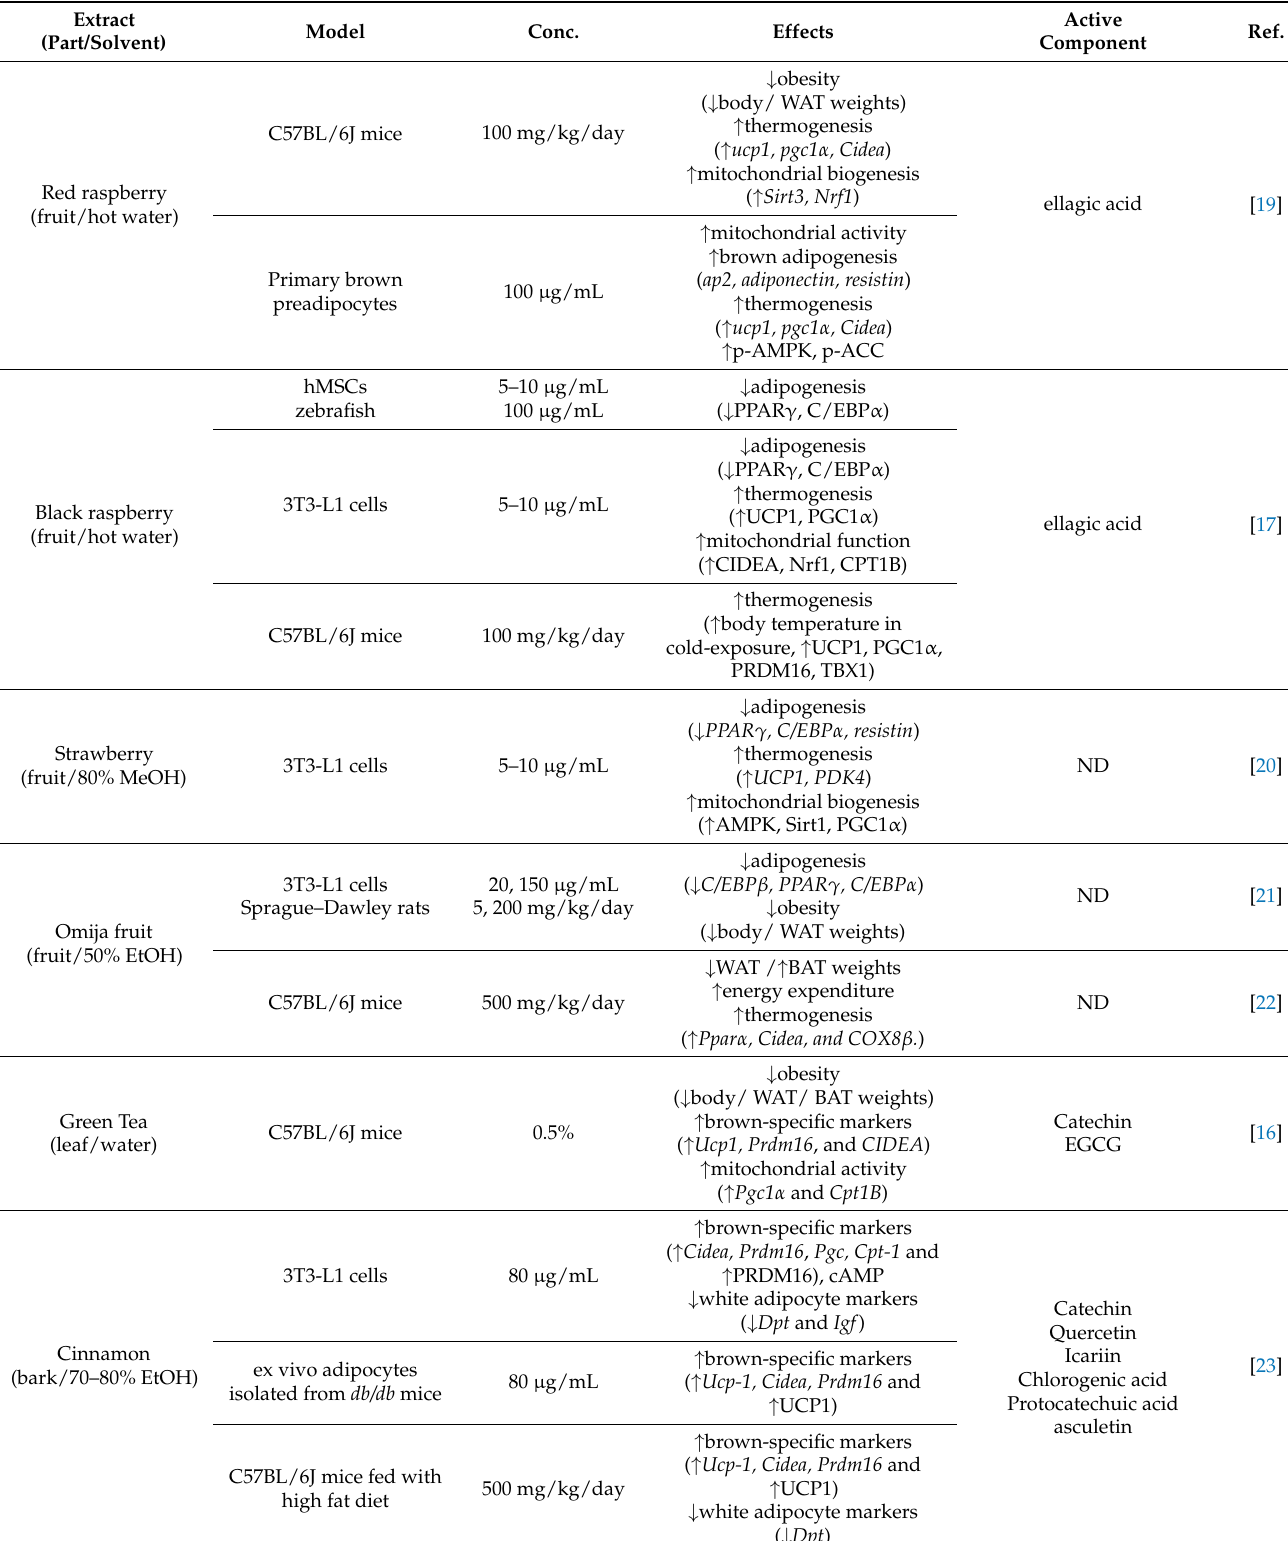
Table 1. Stimulatory effects of edible extracts on adipocyte